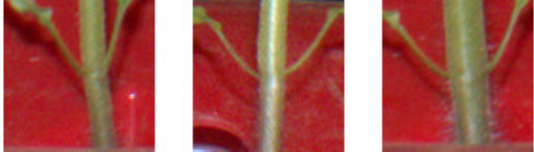
Figure 7. Examples of cotyledonary node